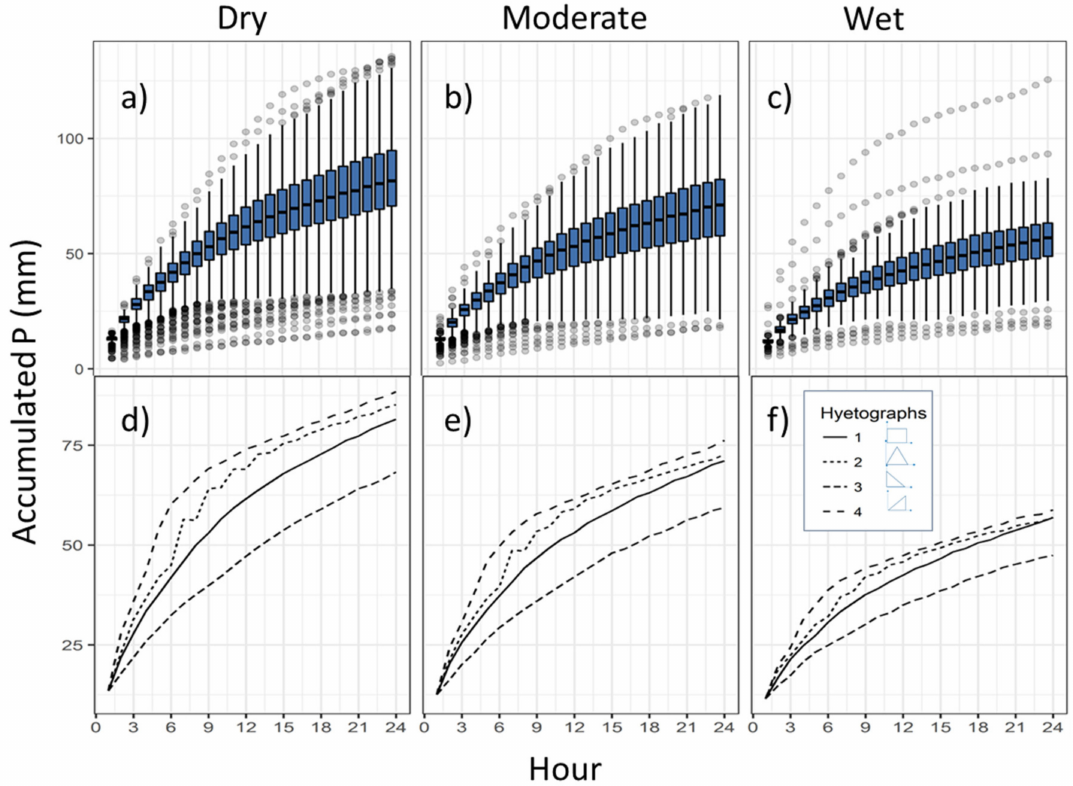
Figure 4. Rainfall threshold for different AMCs and hyetotypes: ( a – c ) Threshold ranges of the study period for different AMC types exemplary of hyetotype 1; ( d – f ) rainfall threshold (median values) for different AMCs because of the different P configurations